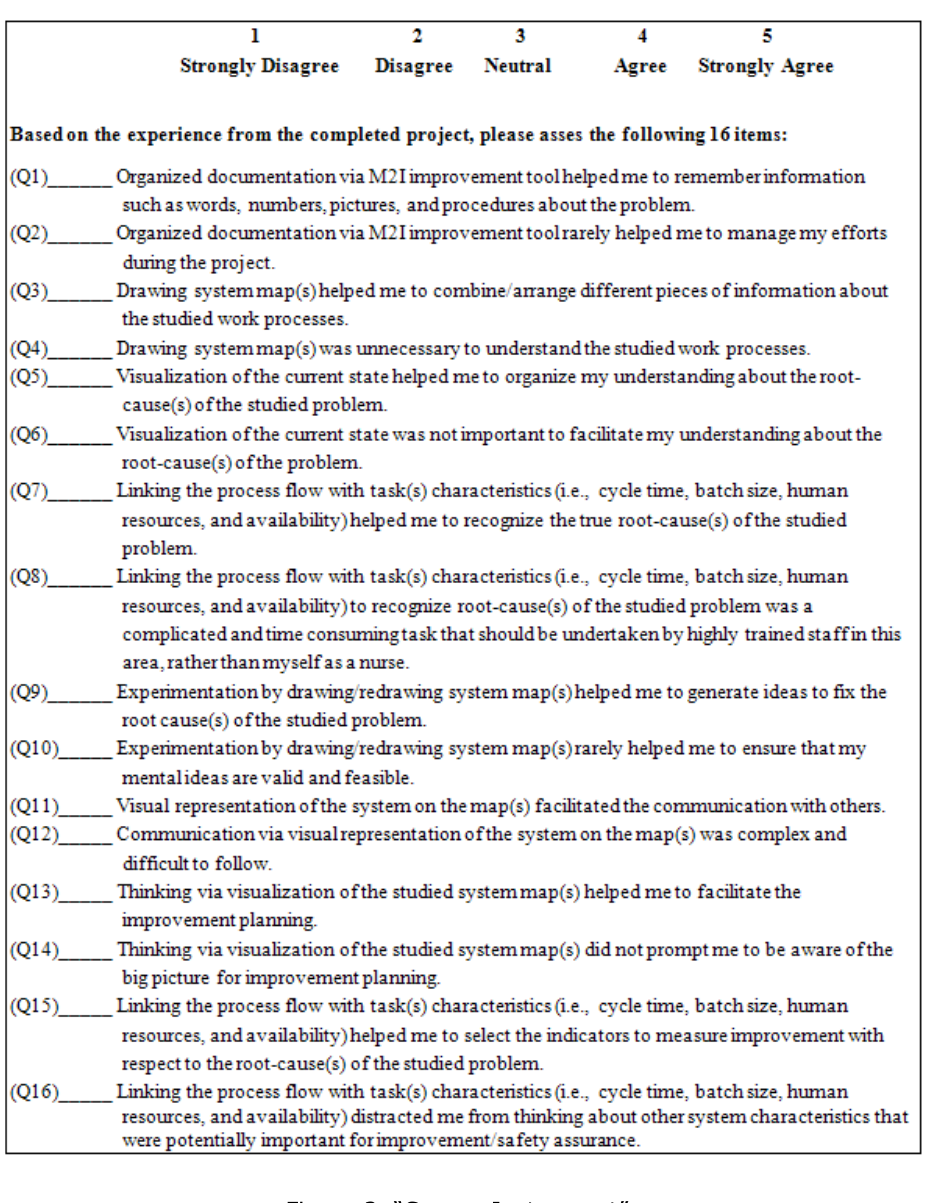
Figure 2. “Survey